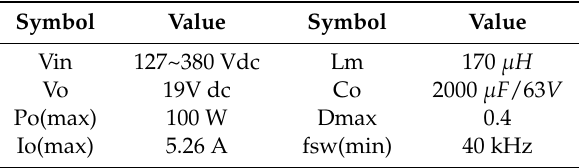
Table 1. Converters